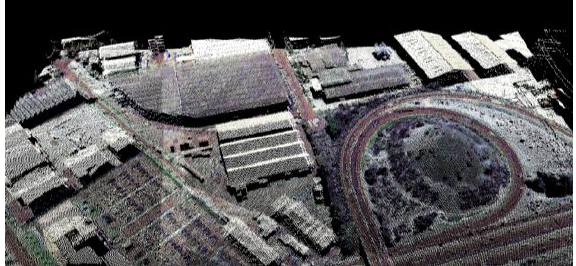
Figure 6. LiDAR point cloud colourised by registered